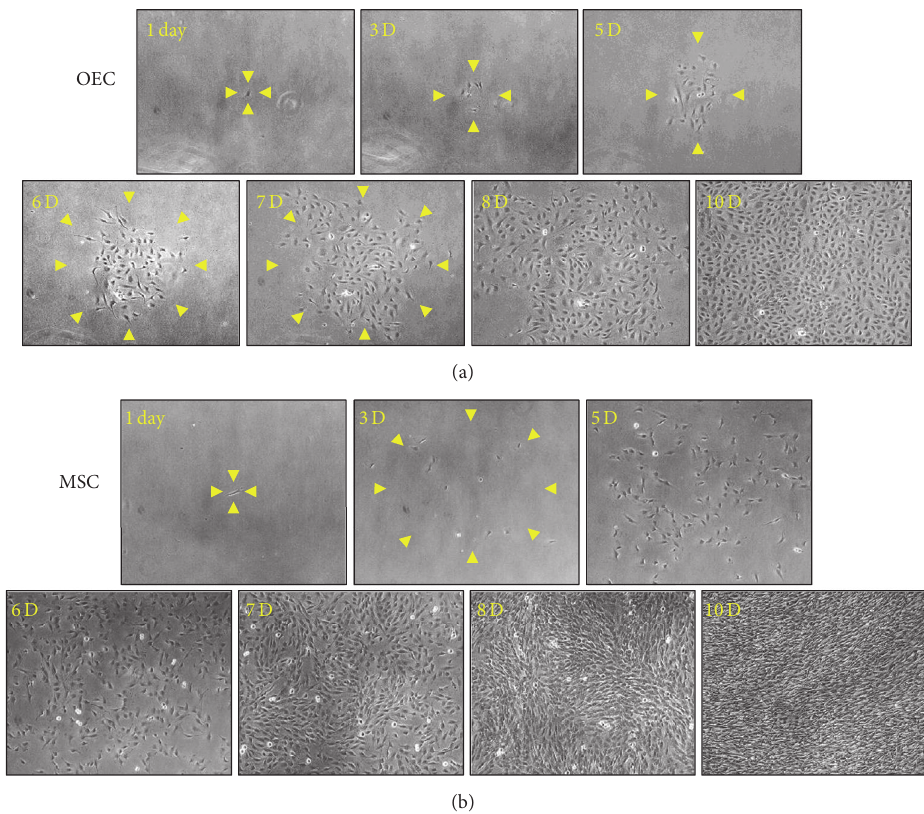
Figure 5: Representative colony formation assay of OECs or MSCs derived from CKL − cells. (a, b) Single OECs or MSCs differentiated from CKL − cells were cultured, and cell growth was analyzed at each time point. Arrowheads indicate the boundary of